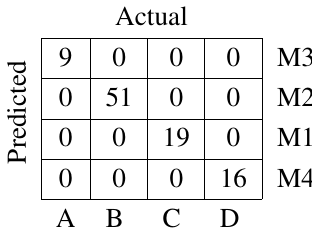
Figure 8. Confusion matrix for DTW and ESOM-based clustering.